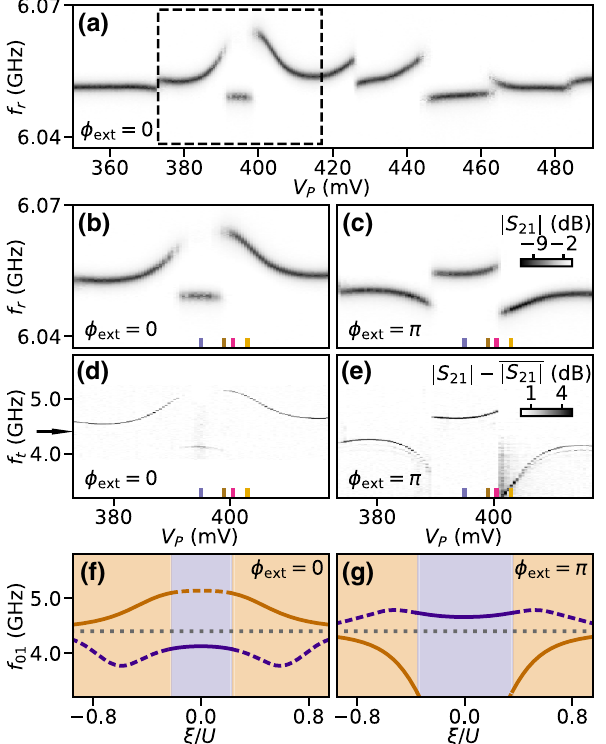
FIG. 3. Spectroscopy of the resonator and the transmon. (a) The V P dependence of single-tone spectroscopy for φ ext = 0, showing the transition frequency of the resonator. V P is a virtual gate voltage defined as a linear combination of V C and V R (see text). (b) An enlargement of (a) in the plunger-gate range indi- cated with dashed lines in (a). (c) The same as (b) but for φ ext = φ = 0, π . (d) The V ext P dependence of two-tone spectroscopy for showing the transition frequency of the transmon. For each fre- ¯| quency trace, | S 21 | − S 21 | is the magnitude of the transmission , the transmon minus its average. The black arrow indicates f 0 01 frequency set by the reference junction when the quantum dot is pinched off. (e) The same as (d) but for φ ext = π . For (a)–(e), V T = 182 mV and V L = 470 mV. (f) Theoretical estimates of the singlet (orange), doublet (purple), and reference-junction-only (dotted, gray) transmon frequencies as ξ is varied for φ ext = 0. Solid (dashed) lines indicate which quantum dot occupation cor- responds to the ground (excited) state. (g) The same as (f) but for φ ext = π . For (f) and (g), (cid:9)/ h = 46 GHz, U /(cid:9) = 12.2, /(cid:9) = 1.05, and (cid:6) /(cid:9) = 1.12. f (cid:6) L R t and f 01 denote, respectively, the frequency of the second tone in two-tone spectroscopy and the first transmon transition frequency (see